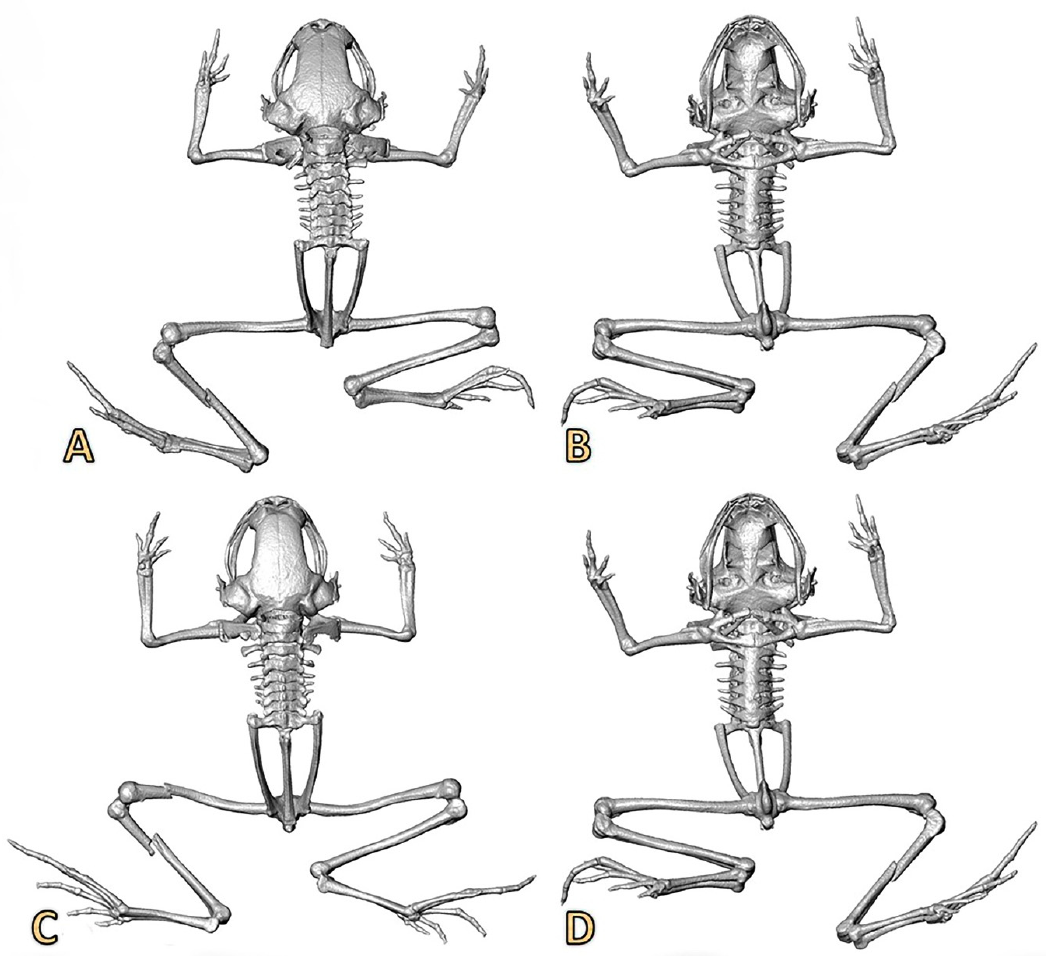
Figure 6. Three-dimensional reconstructions based on µCT data, from the skull and skeleton of two specimens of Noblella losamigos sp. n. ( A , B ) Dorsal and ventral views of specimen MUSM 37355 (SVL 9.6 mm). ( C , D ) Dorsal and ventral views of specimen MUSM 37356 (SVL 9.7 mm).